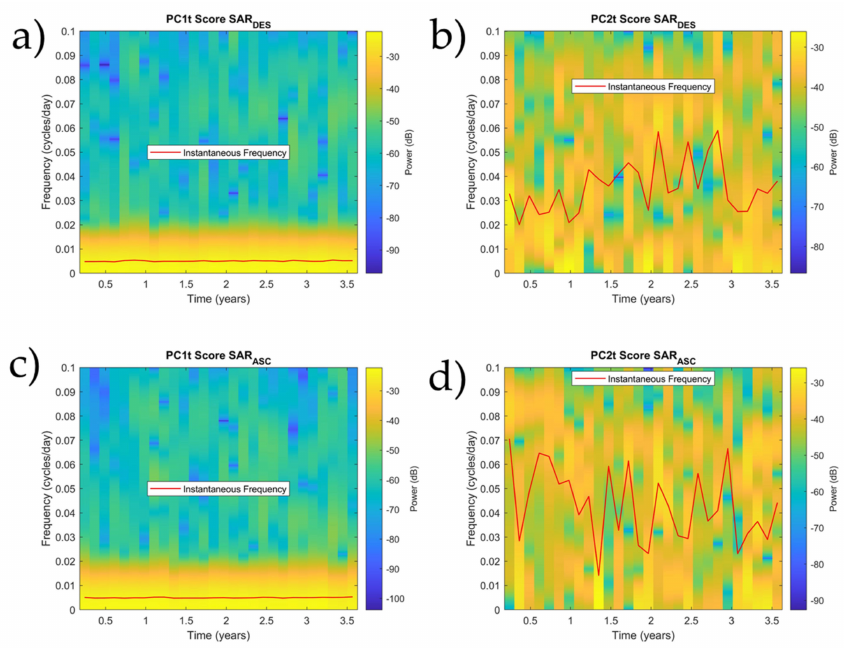
Figure 20. Power spectrogram obtained from the PC1 and PC2 temporal scores at Start Bay area from SAR DES ( a , b ) and ASC ( c , d ) datasets. The red line represents the instantaneous frequency and yellow to blue represents decreasing signal